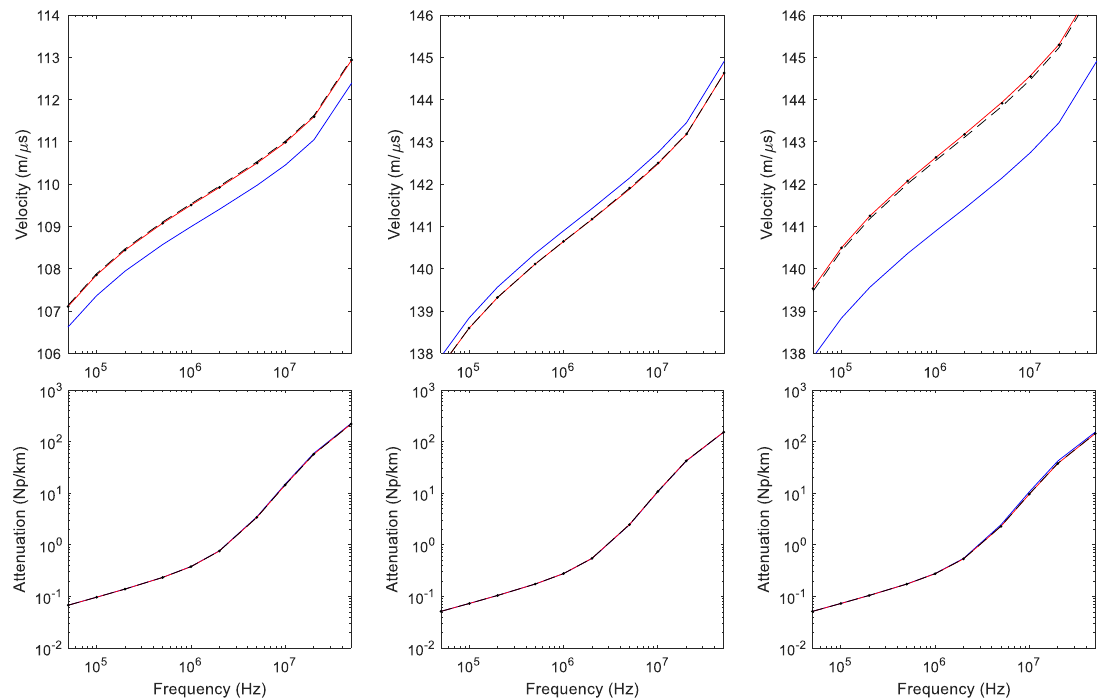
Figure 6. Propagation velocity and attenuation of the modes in (6) for a balanced load (blue curves) and an unbalanced load (red curves); dashed and dotted curves represent the results from first and second-order Rayleigh–Schrödinger perturbation analysis, respectively.